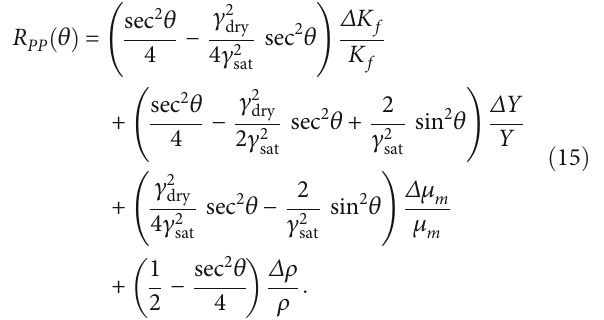
/ μ of dry rocks dry